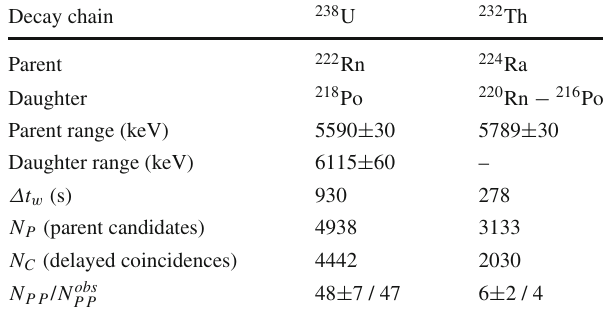
Table 1 Summary of the parameters used to identify delayed coinci- dencesandthecorrespondingnumericalresults.AsdiscussedinSect.5, the ratio between N P and N C depends on the contaminant position. Moreover, in the 232 Th chain, the daughter selection is further con- strained to detect 3 consecutive α -decays, the third occurring with a Δ t > 80 ms Decay